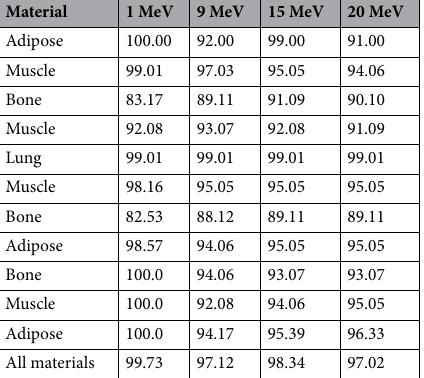
Table 2. Percentage of the HH-benchmark voxels satisfying the AAPM 2% criterion for a relative BFP-MC error below 2% . Listed values include buildup, interfaces and straggling regions. From top to bottom, the materials listed are in their order of appearance from left to right in Fig.